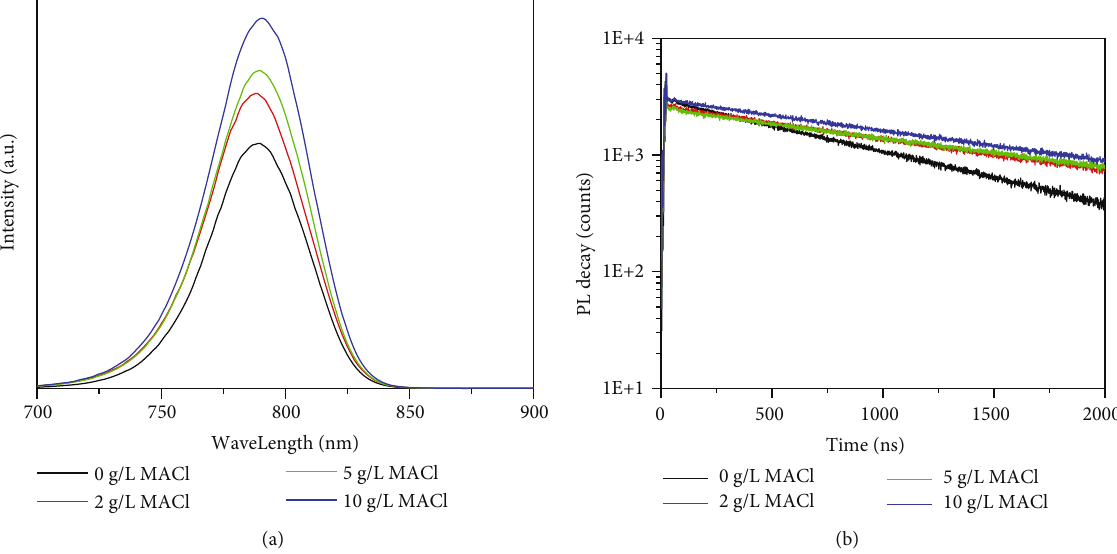
Figure 5: (a) The steady-state PL spectra and (b) TRPL curves of fi lms added di ff erent concentrations of MACl (sample structure: corning